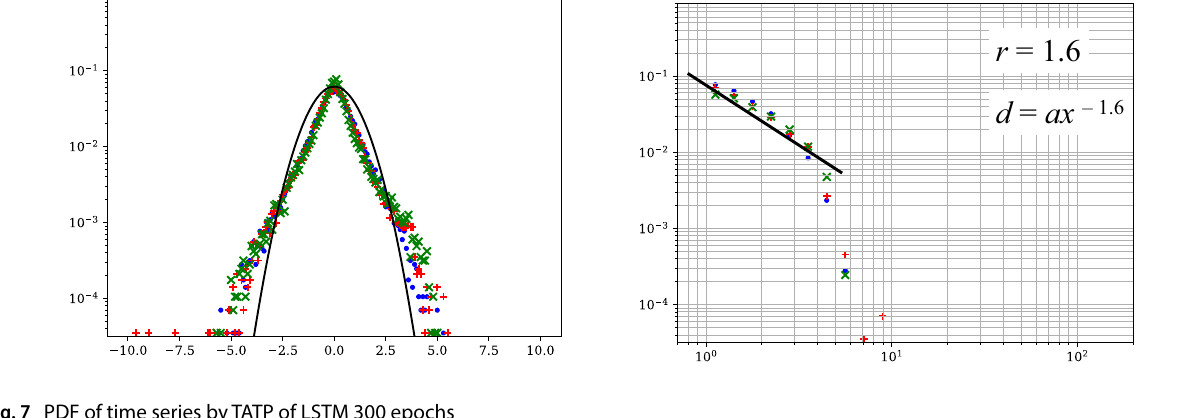
Fig. 7 PDF of time series by TATP of LSTM 300 epochs